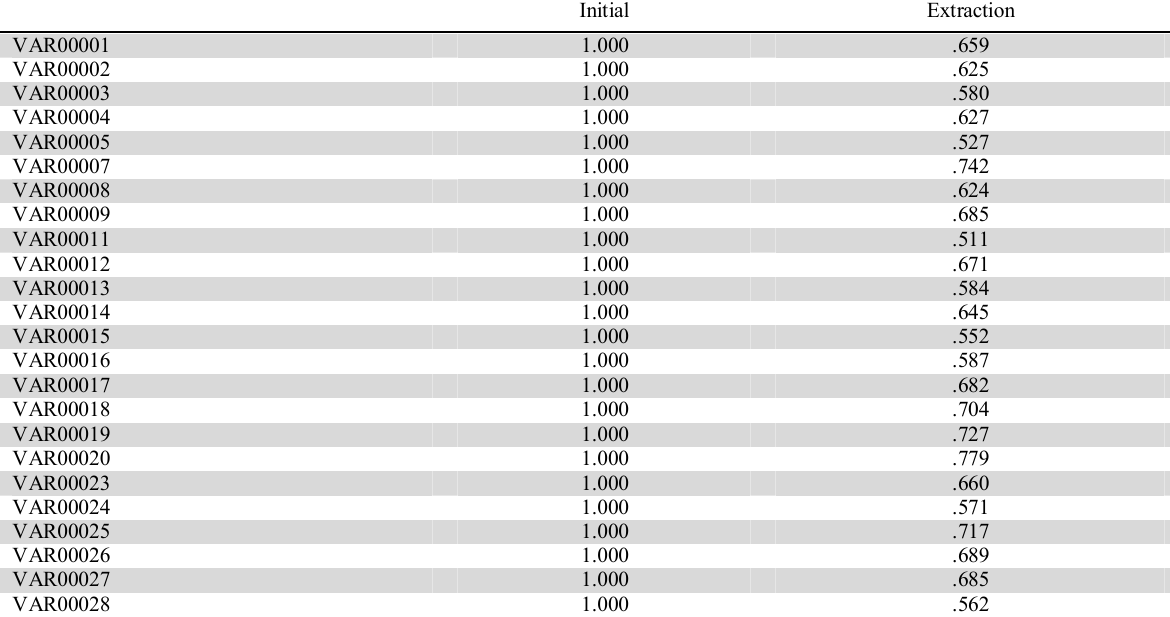
Initial Extraction